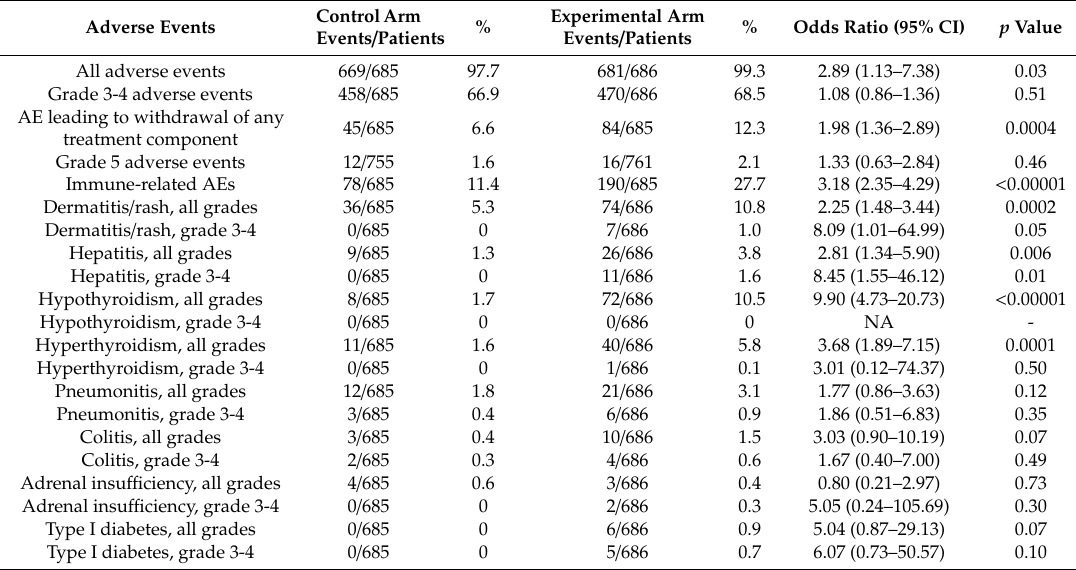
Table 4. Pooled analysis of toxicity data in the safety population of control and experimental